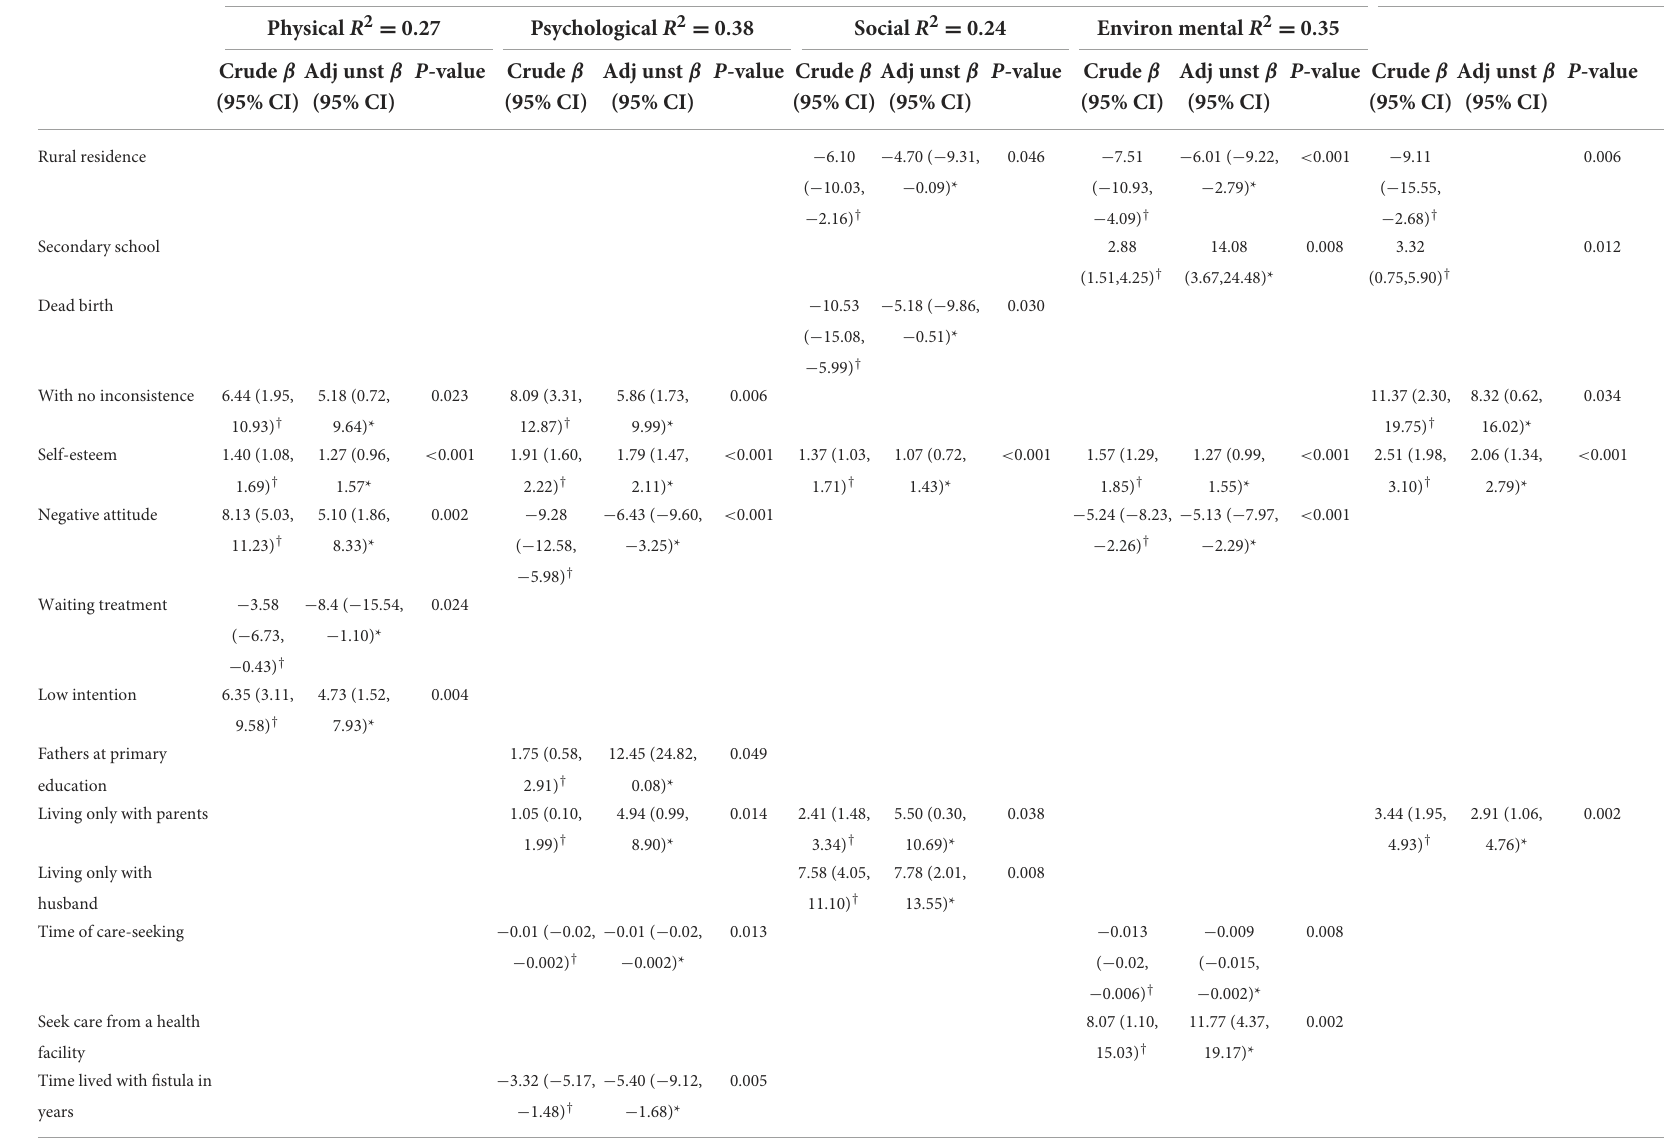
TABLE 3 Predictors of quality of life domains among women with obstetric fistula in Ethiopia, 2019 ( n = 478). Variables Four domains of quality of life Overall quality of life R 2 =